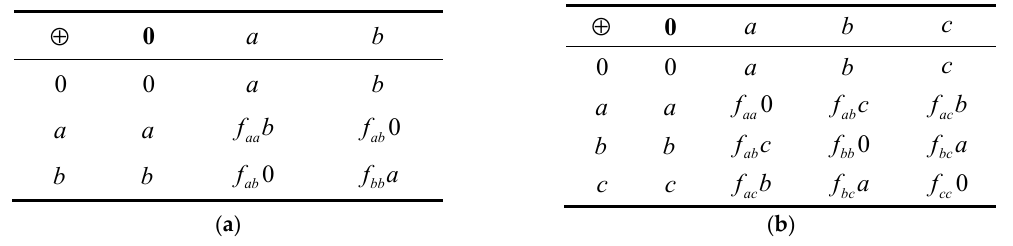
Table 1. Addition tables for the proposed indexing method: ( a ) for digits of aperture 3; ( b ) for digits of aperture 4